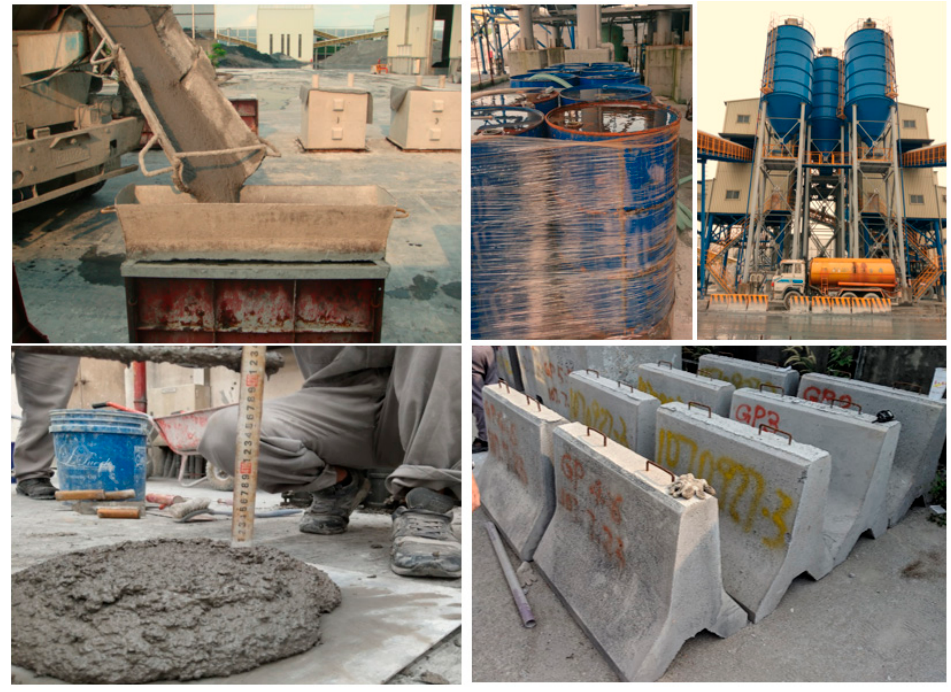
Table 12. Fresh and hardened properties of marble-based geopolymer mortar for making Jersey barriers at a ready-mixed plant.